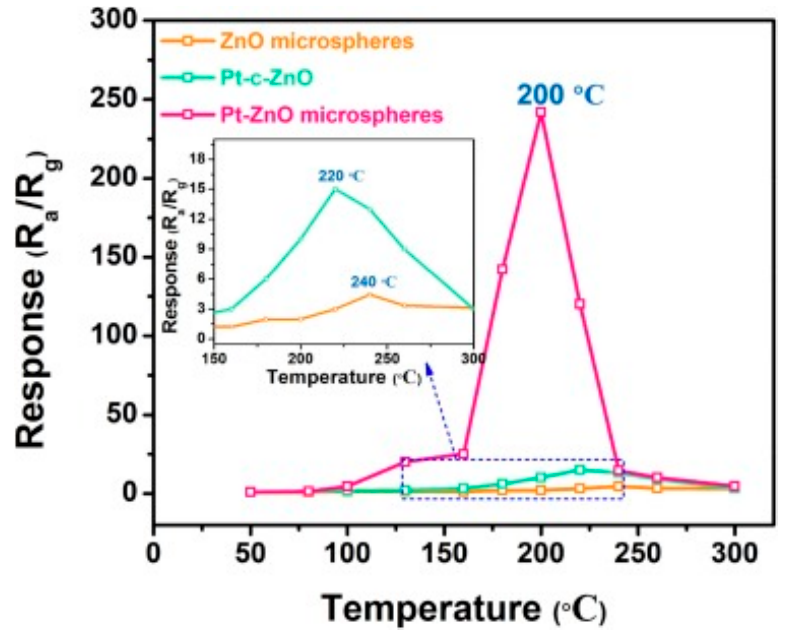
Figure 8. The response curves of the ZnO, Pt-c-ZnO, and Pt-ZnO microspheres to 100 ppm TEA at various temperatures [87].